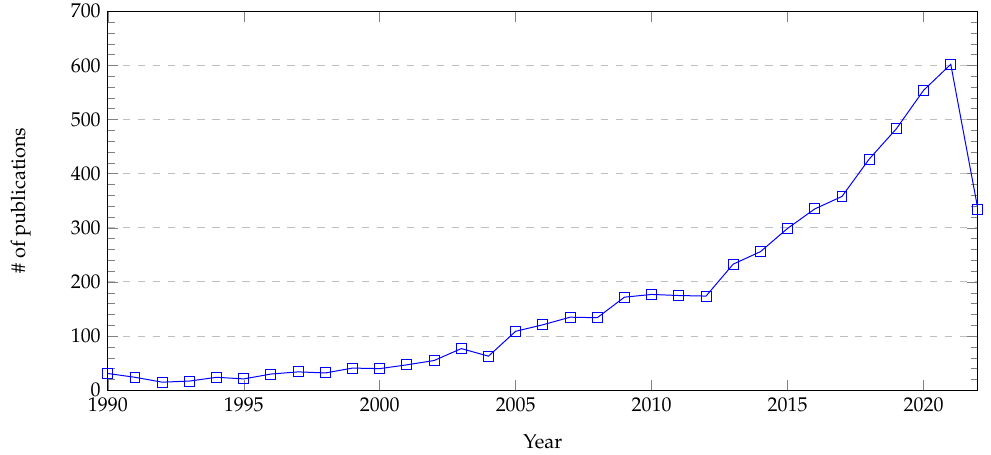
Figure 1. A timeline of PPG-related publications every year from 1990 to 2022. For 2022, the number of publications was recorded up to 26 July